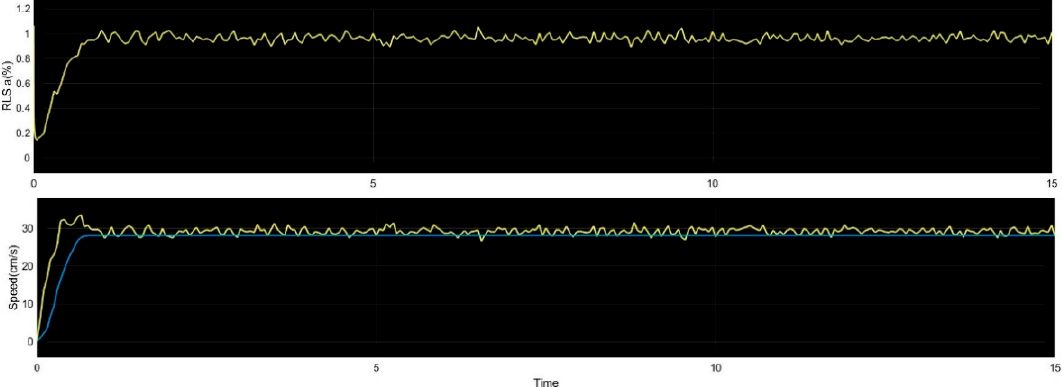
Figure 8. Estimated value by RLS method, motor speeds, and the vehicle speed of the third motor.